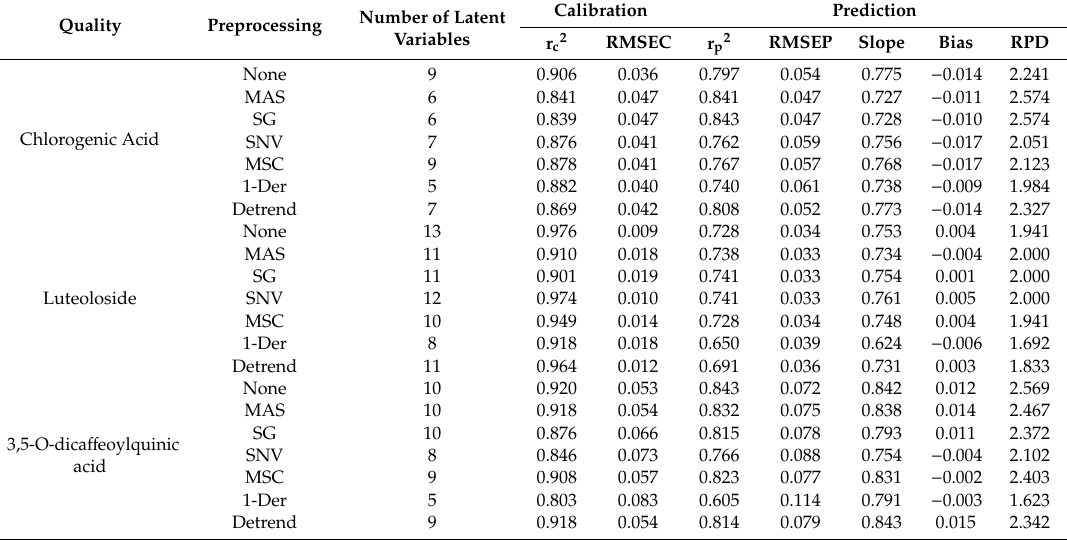
Table 2. Results of PLS models with di ff erent data preprocessing methods.